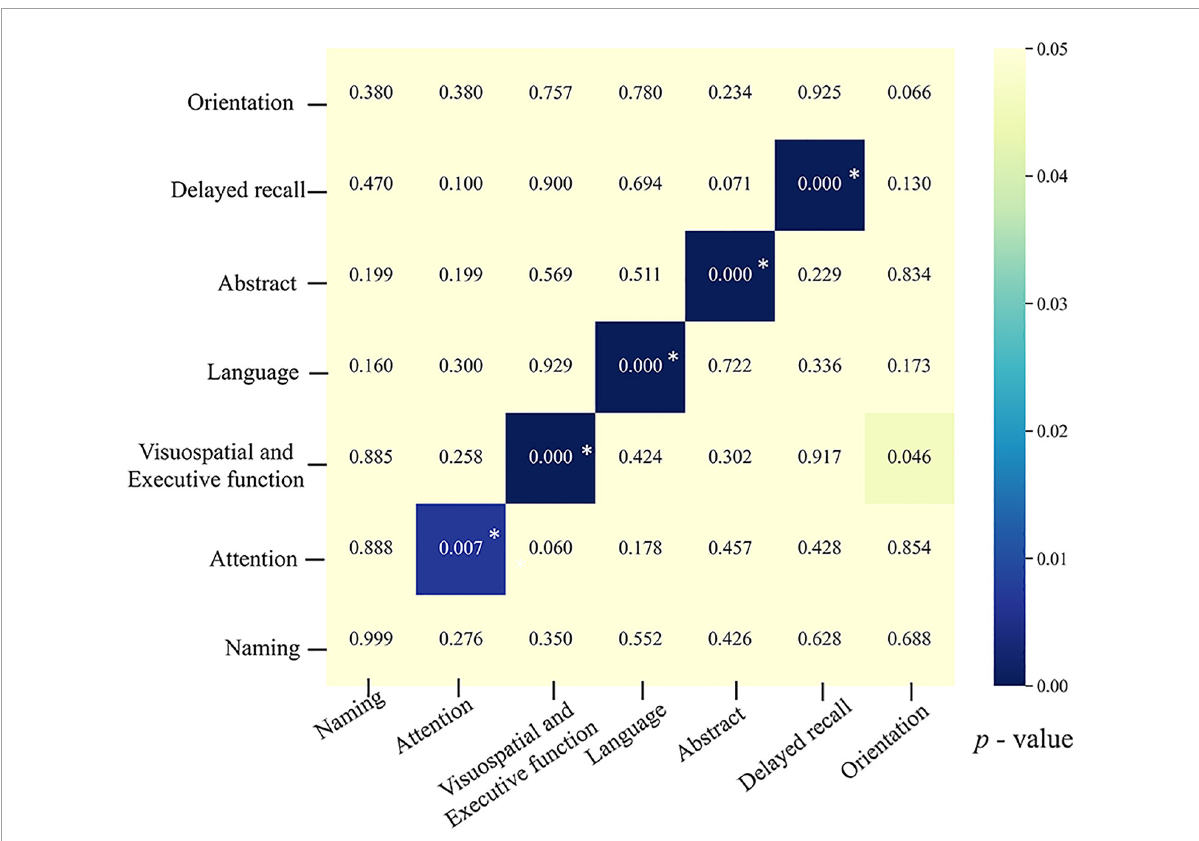
FIGURE3 Heatmap showing outcomes of predictors of post-operative decline in specific MoCA domains. The x-axis shows post-operative decline in seven different MoCA domains based on which cognitive-decline dichotomy was made. The y-axis lists seven potential predictors. The color of the blocks reflects the p -value from comparisons of each potential predictor between the cognitive-decline group and the non-decline group, with darker color indicating smaller p -values. After Bonferroni correction, p < 0.008 (0.05/7) was considered significant. Blocks with ∗ indicate factors that remained statistically significant in the multivariate regression